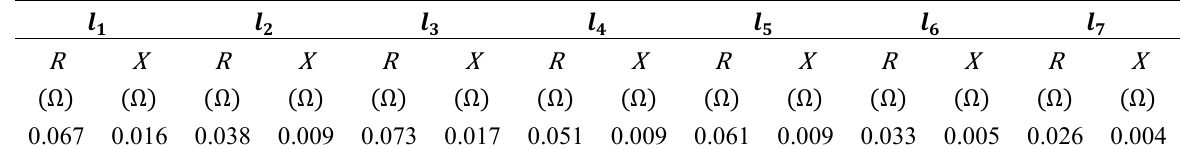
Figure 3. Test distribution system. Table 4. Electric parameters of the lines.